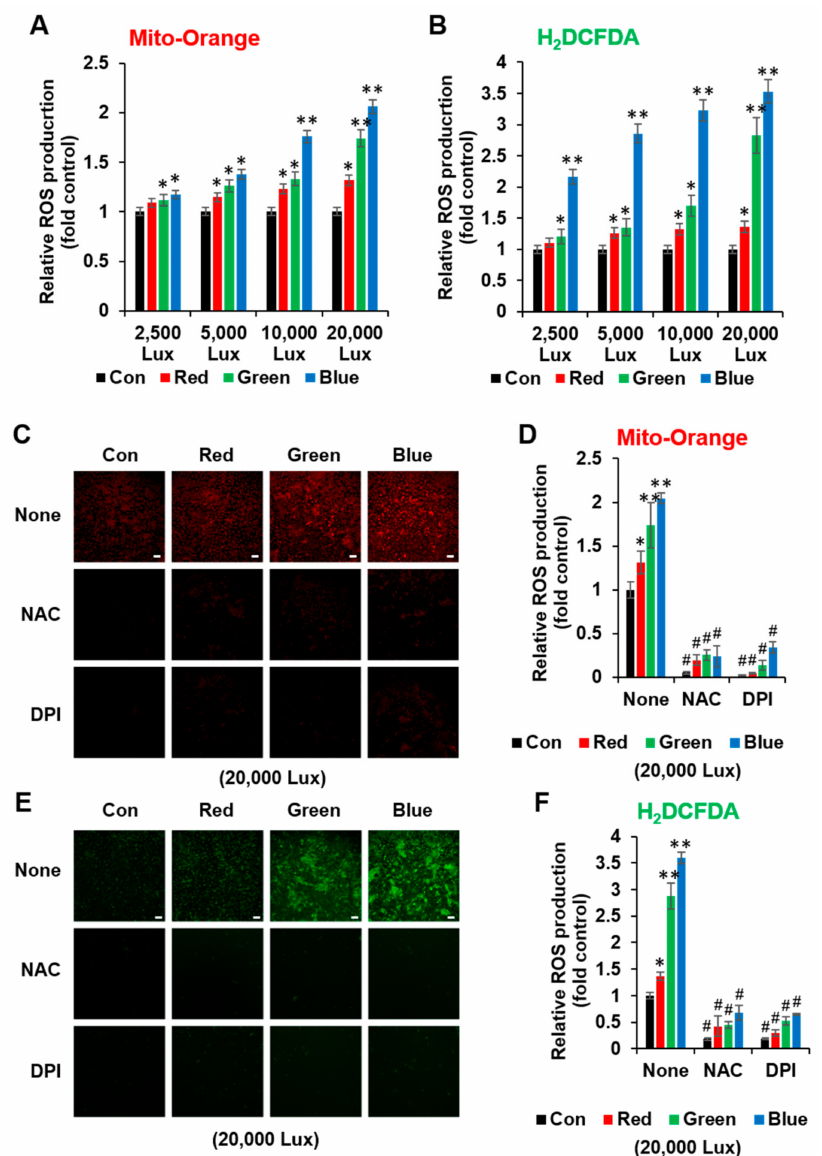
Figure 2. Red, green, and blue LED light exposure produced different levels of ROS. HaCaT cells cultured in a 96-well plate were exposed to indicated LED lights for 1 h and then stained by Mito- Orange ( A , C , D ) or H 2 DCFDA ( B , E , F ). HaCaT cells were pretreated with NAC (10 mM) or DPI (10 µ M) for 1 h before cells were exposed to LED lights ( C – F ). ROS production was measured by using a fluorescence plate reader ( A , B ) or fluorescence microscopy. Scale bar, 100 µ m. ( C , E ) and plotted as a bar graph ( D , F ) to present the fold changes in ROS production in samples exposed to LED lights, relative to unexposed control cells ( n = 3, ± SD). * p < 0.01 and ** p < 0.001 vs. control. None vs. NAC or DPI, # p <